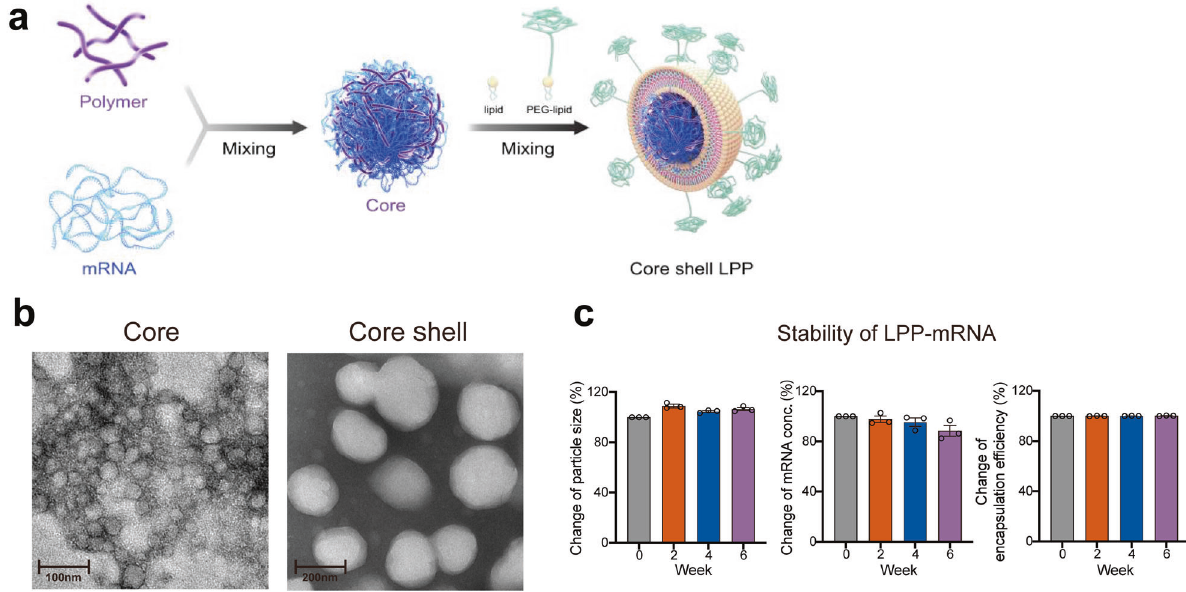
Fig. 1 Preparation and characterization of a “ core – shell ” -structured LPP-mRNA vaccine. a Schematic view on preparation of SW0123 mRNA vaccine. b Representative transmission electronic microscopy (TEM) image of SW0123 vaccine particles. Left: mRNA/SW-01 complexes. Right: LPP particles with a complex lipid cover. c Time-dependent changes in particle size, mRNA concentration and encapsulation ef fi ciency of SW0123 upon storage at 4